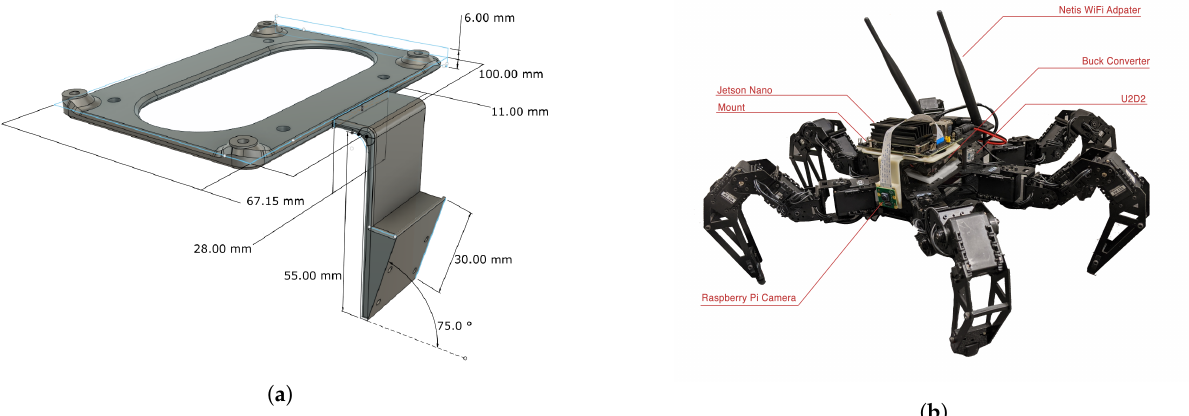
Figure 3. Hexapod physical augmentations and peripherals ( a ) CAD rendering of physical mounts for peripherals ( b ) modified PhantomX platform with Jetson Nano controller, Raspberry Pi Camera V2, buck convereter, U2D2, and Netis AC wireless adapter.